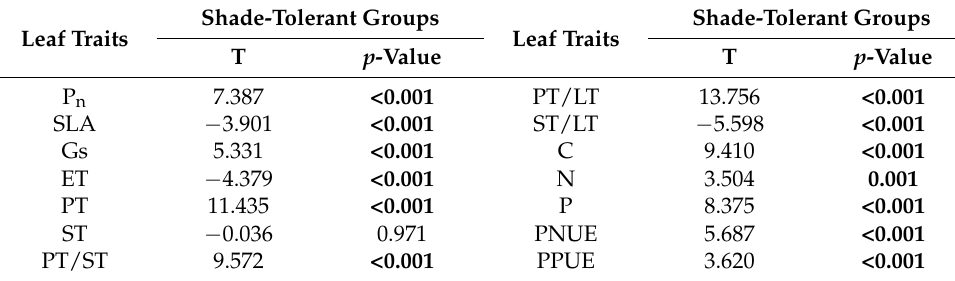
Bold indicates a significant difference ( p < 0.05). P n , maximum net photosynthetic rate based on mass; ET, epidermis thickness; PT, palisade tissue thickness; ST, spongy tissue thickness; PT/ST, palisade–spongy tissue ratio; PT/LT, palisade tissue–leaf thickness ratio; ST/LT, spongy tissue–leaf thickness ratio; C, carbon content; N, nitrogen content; P, phosphorus content; PNUE, utilization efficiency of photosynthetic nitrogen; PPUE, utilization efficiency of photosynthetic phosphorus; (PPUE) SLA, specific leaf area; G s , stomatal conductance based on mass.